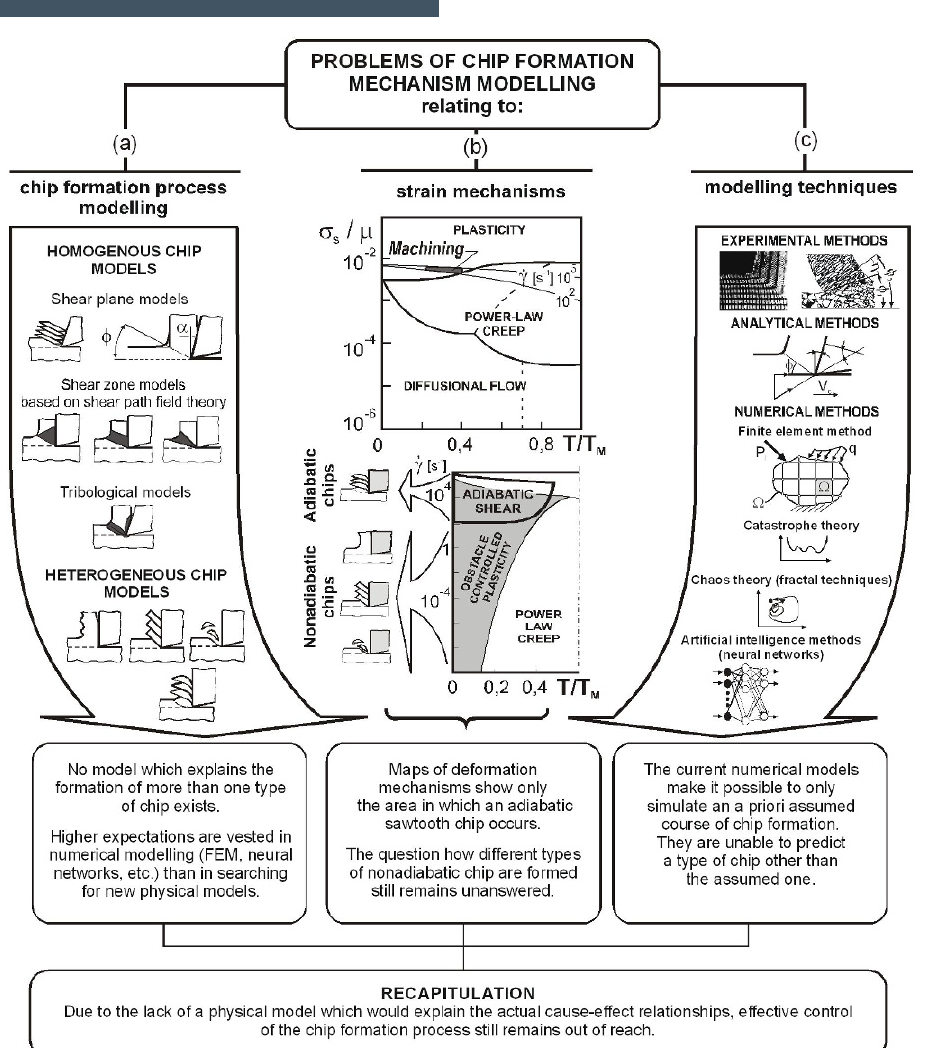
Figure 6. Synthetic illustration of problems related to chip formation mechanism